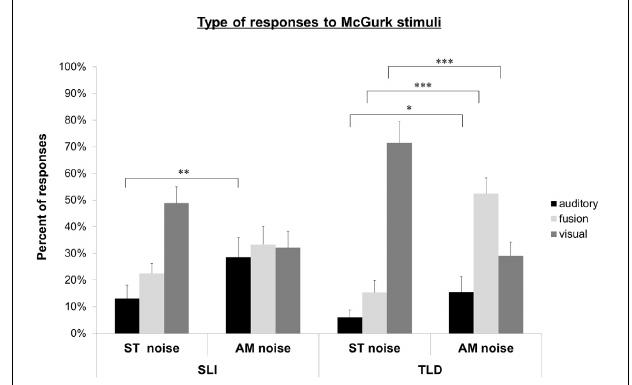
FIGURE 1 | Experiment 1. Auditory, fusion, and visual responses to McGurk stimuli for SLI and TLD groups in ST and AM noise conditions. ∗ p < 0 . 05; ∗∗ p < 0 . 01; ∗∗∗ p < 0 . 001.